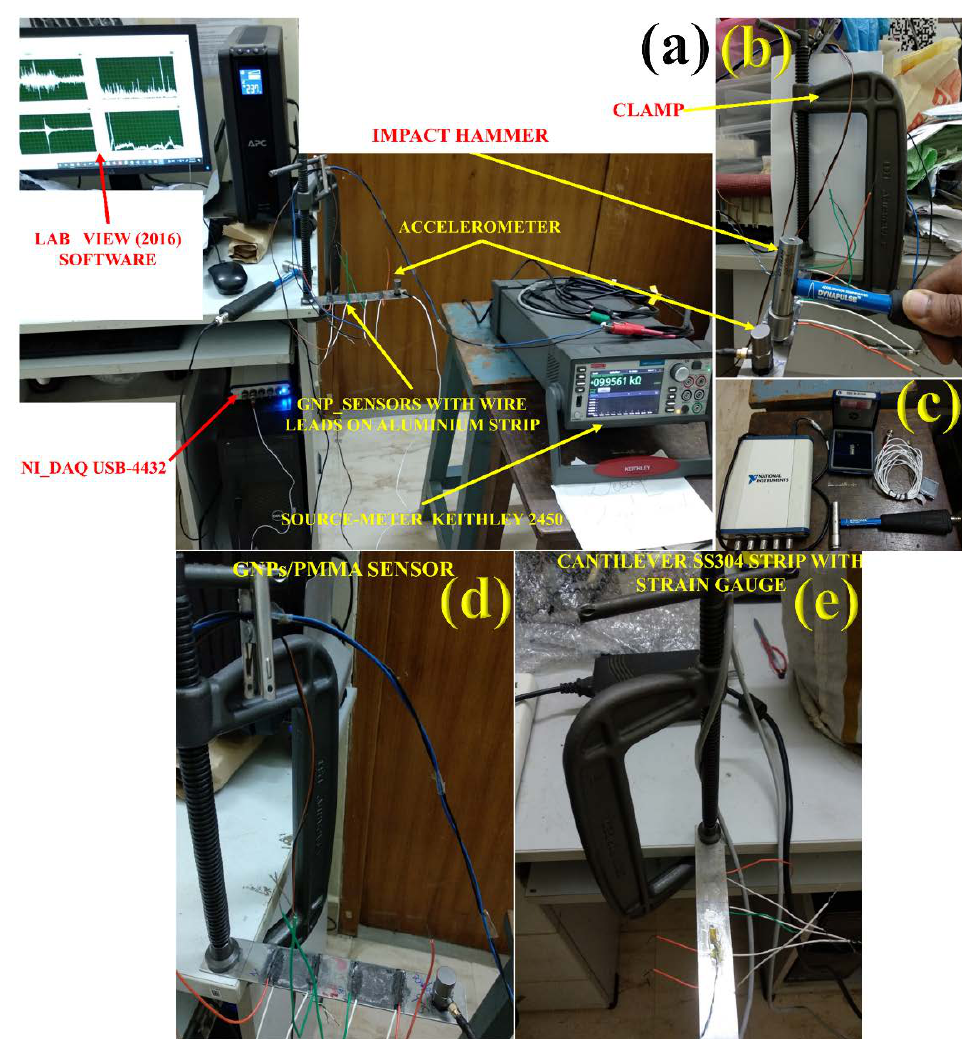
Figure 3. Experimental setup for natural frequency calculation of SS304 strip: ( a ) LabVIEW (2016) software and NI-DAQ USB-4432 used for natural frequency calculation with Keithley SourceMeter- 2450 for electrical resistance calculation; ( b ) clamp being used for fixing SS304 strip with accelerometer and impact hammer; ( c ) electronic gadgets for impact hammer method (DAQ USB-4432), wax for fixing accelerometer, cable chords for accelerometer and impact hammer; ( d ) GNPs/PMMA sensor fabricated and accelerometer fixed upon SS304; ( e ) industrial strain gauge fixed to SS304 for comparative study.